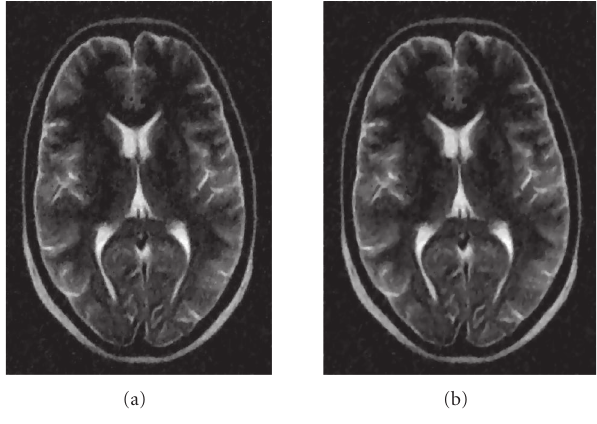
Figure 3: (a) Denoised image by TV wavelet with fixed fitting pa- rameter λ j , the PSNR = 10 . 05(dB). This image and the PSNR mea- surement are very similar to those of the regular TV scheme with the same parameter. (b) Denoised image by TV wavelet with vari- able fitting parameter λ j on di ff erent wavelet scales, the PSNR = 10 .